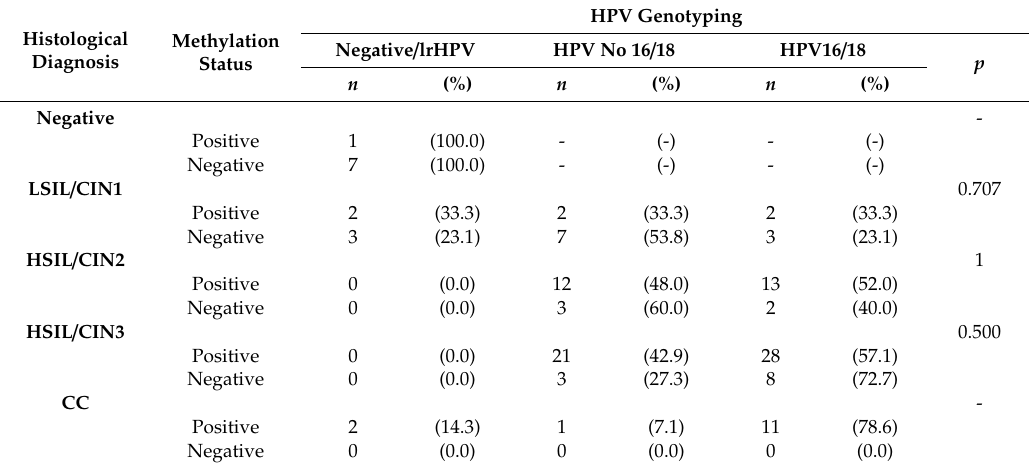
Table 3. Correlation between HPV genotyping and methylation of at least one biomarker in the di ff erent diagnostic groups. HPV: Human papillomavirus; lrHPV: Low-risk HPV; LSIL / CIN1: